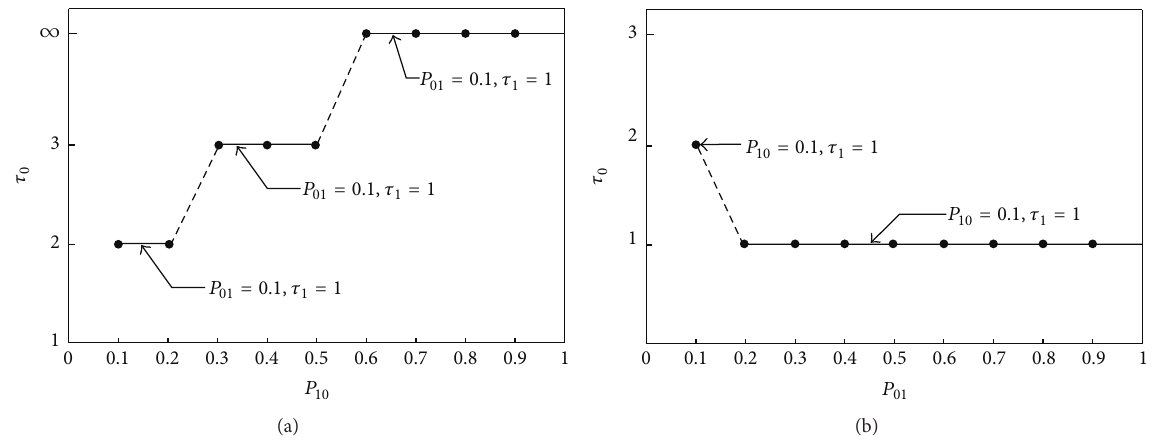
Figure 4: Optimal interval of combination (𝜏 0 , 𝜏 1 ) with different (𝑃 01 , 𝑃 10 )